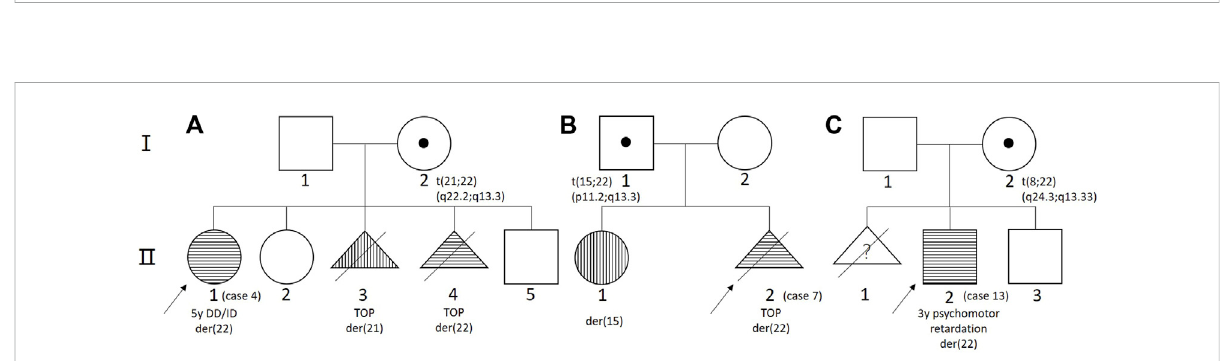
FIGURE 2 The pedigree of three cases from three families. (A) Family 1; (B) family 2; and (C) family